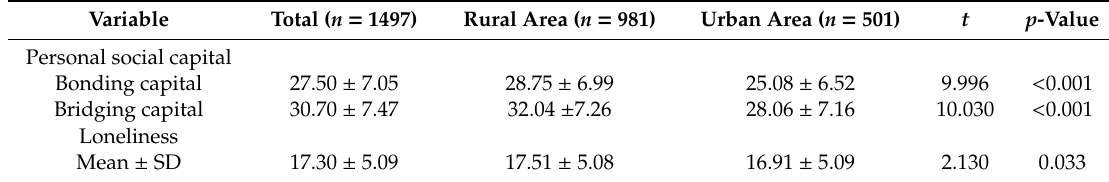
Table 2. The distribution of bonding / bridging social capital level and loneliness among participants from rural and urban